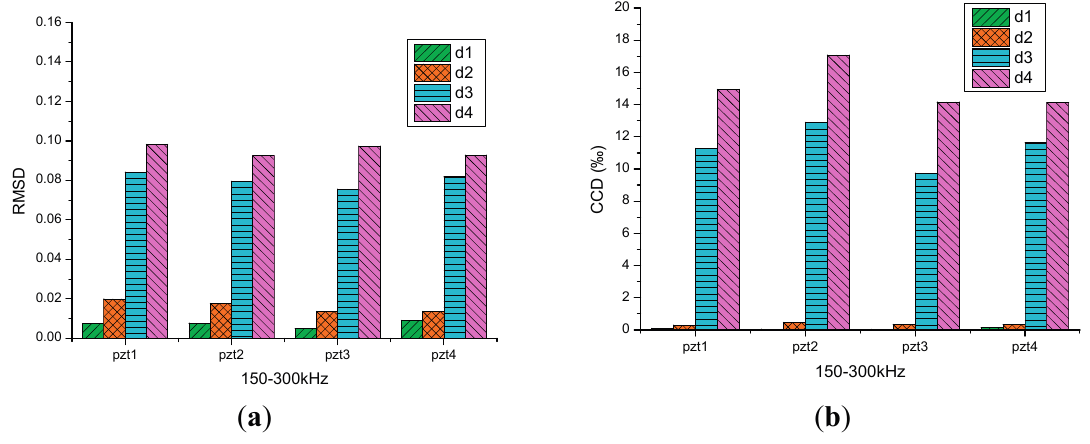
Figure 6. Histogram of the RMSD, CCD and R y / R x indices of damage conditions d1–d4.